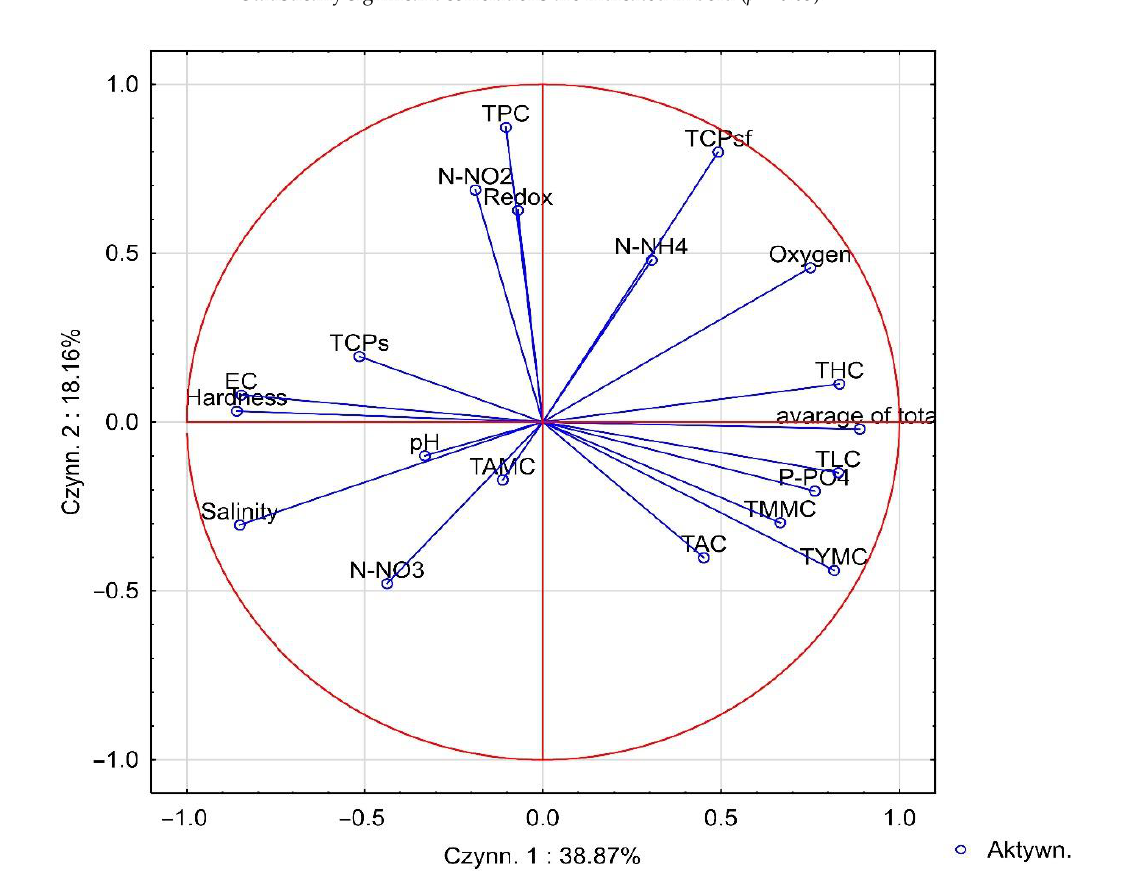
Figure 2. Graphical interpretation of principal component analysis.